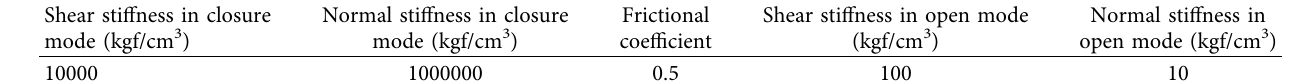
Table 6: Material properties of the bond element.